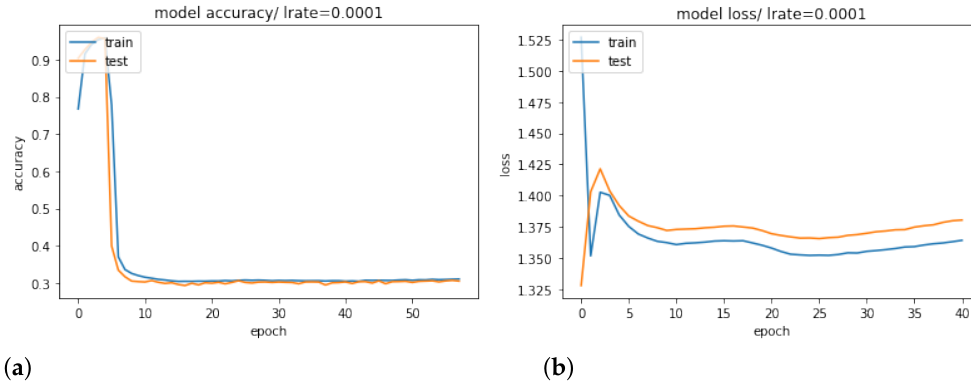
Figure 10. lr = 10 − 4 . ( a ) Train accuracy: 0.310. ( b ) Test accuracy: 0.305.